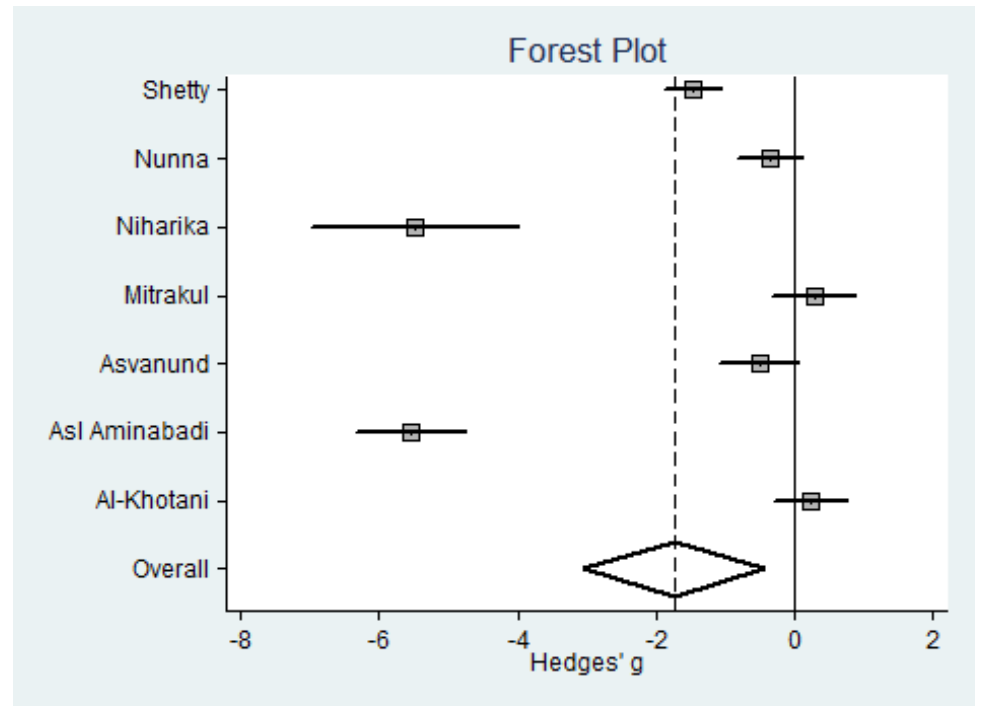
Figure 3. Forest plot for anxiety in children.